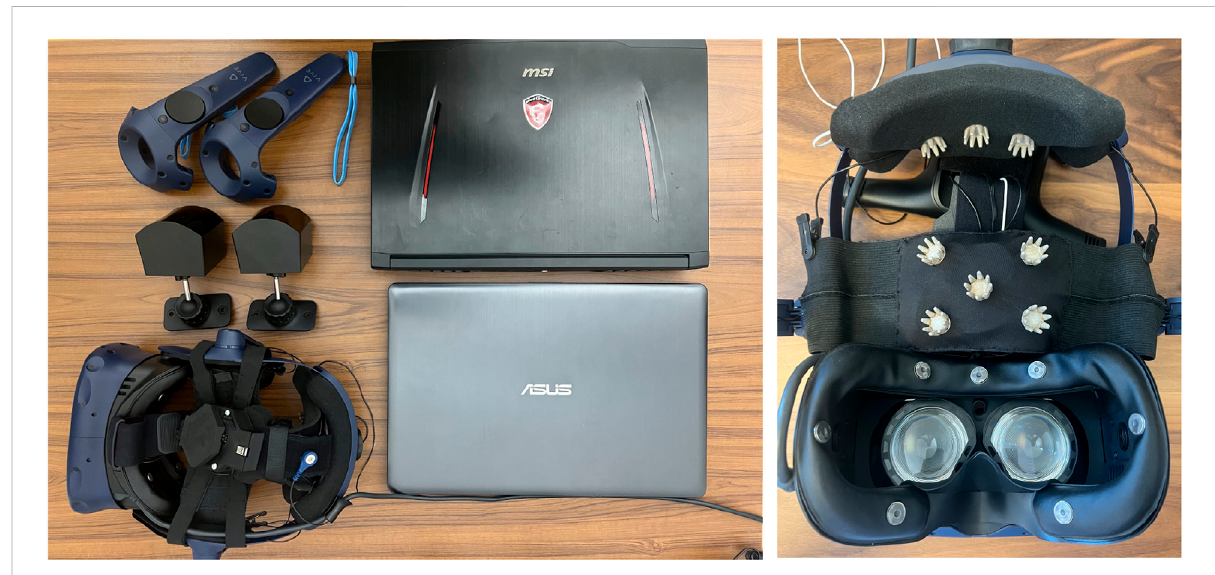
FIGURE 3 Ontheleft: entire equipment drop off atparticipant ’ shomeincluding twolaptops, base stations, controllers and theiHMD; on theright:16 ExG sensor-equipped VR